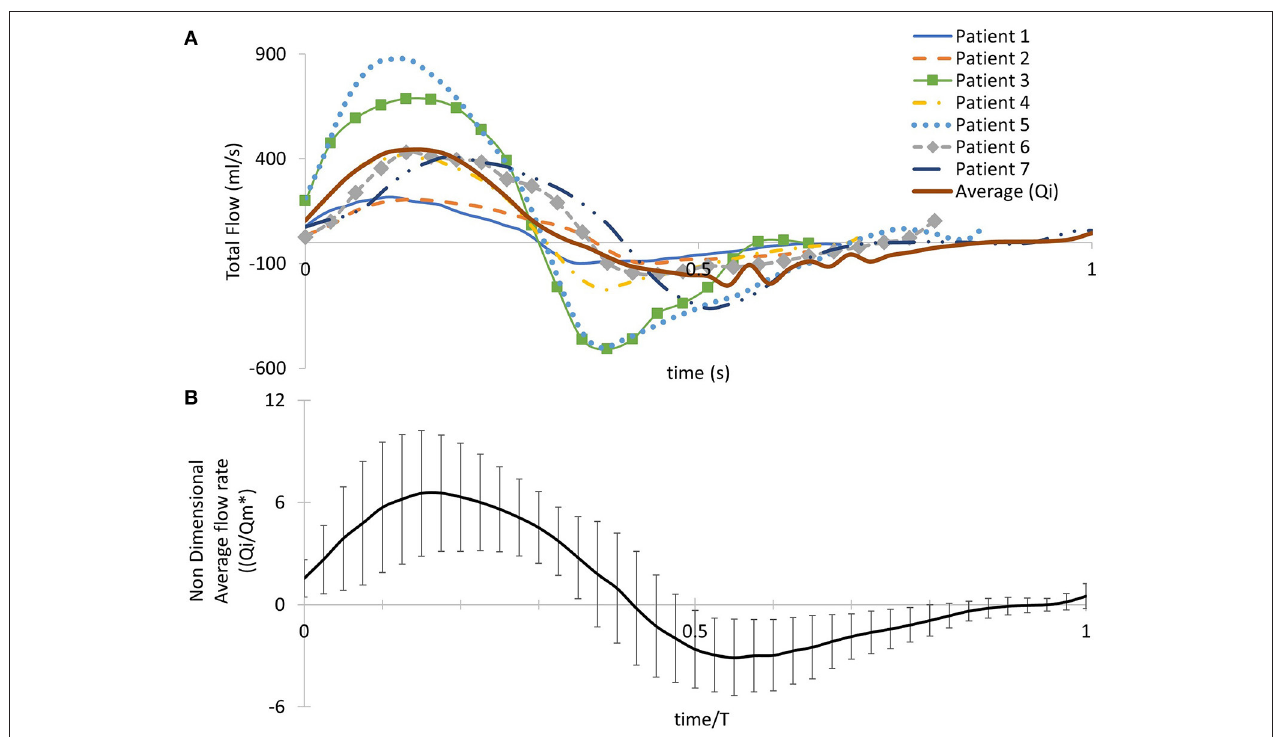
FIGURE 2 | (A) Patient-specific pulsatile inlet flow rate waveform for all seven subjects and an averaged flow rate waveform ( Q i ) derived from the seven patient-specific waveforms. (B) The averaged flow rate waveform normalized with the mean value of the average flow rate over the cardiac cycle Qm *. Time was normalized with the period of the cardiac cycle of each patient. Error bars represent the standard deviation of the patient-specific flow waveforms from the average flow waveform.